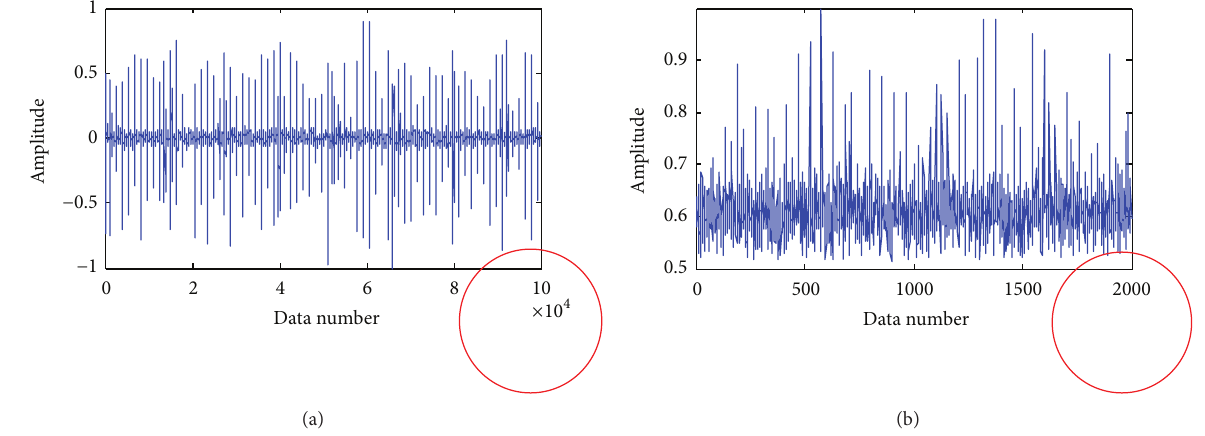
Figure 11: (a) Original signals and (b) symptom parameter wave using shape